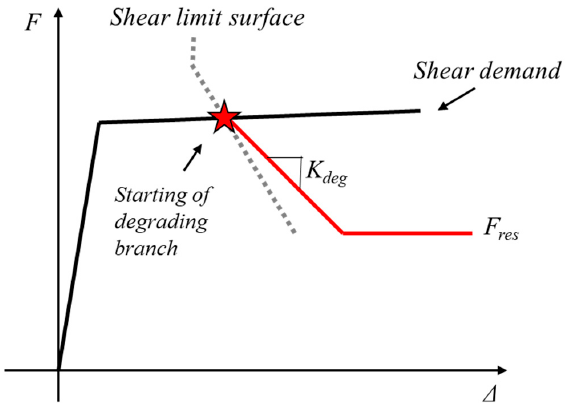
Figure 11. Redefinition of backbone after failure.